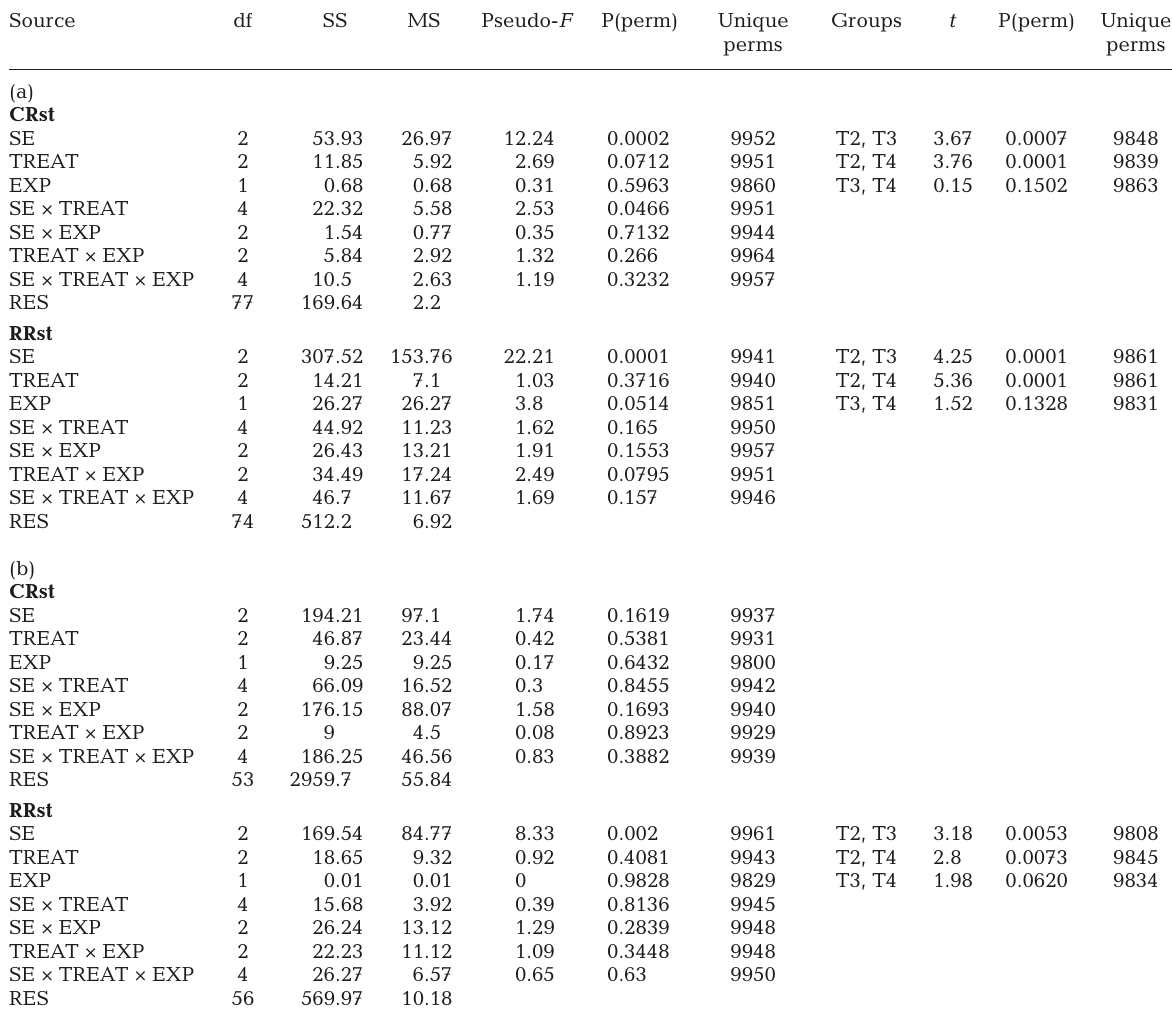
Table 2. PERMANOVA of results and group analysis for standardized (st) clearance rate (CR, l h −1 g WW −1 ) and respiration rate panels submerged during different seasons (Group B). SE: season; TREAT: O 2 treatment, EXP: exposure time; RES: residuals. See Table 1 for further